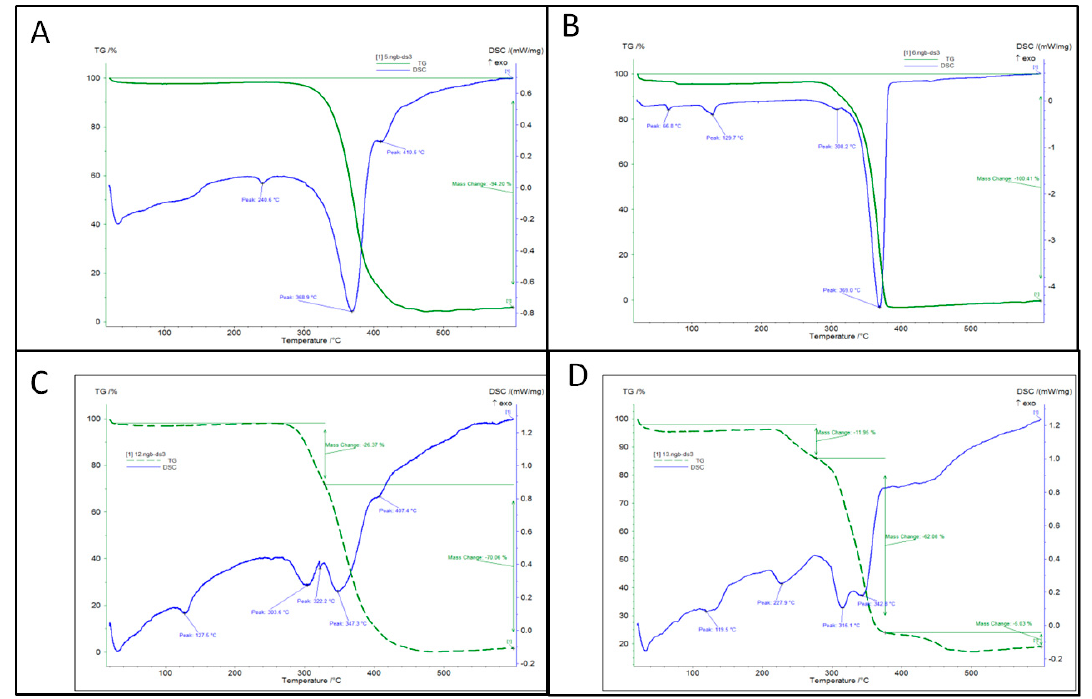
Figure 6. Representative TGA and DSC curves of TPU ( A ); PLA ( B ) and TPU/PLA 80/20 ( C ); TPU/PLA 20/80 ( D ) blends.